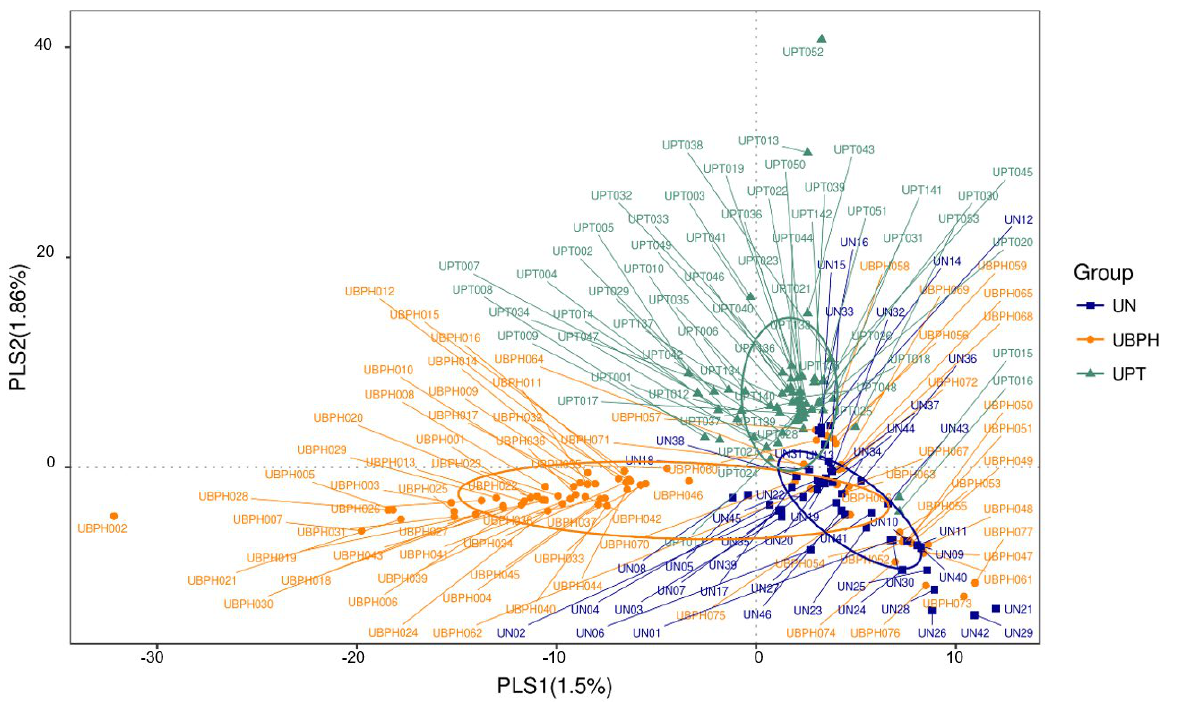
Figure 4. Urine sample PLS-DA plot for visualizing the difference among three groups. Each spot represents a urine sample collected from a project participant. UBPH: Urine from a patient with BPH. UN: Urine from control group. UPT: Urine from a patient with prostate cancer.